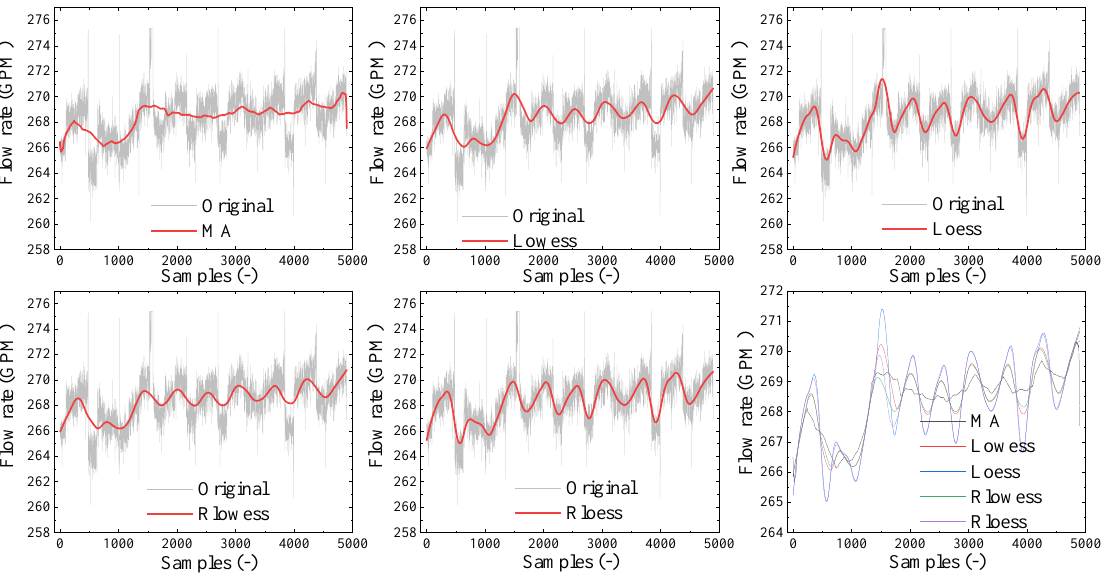
Figure 11. Data smoothing results of the different methods when the parameter is set too large.